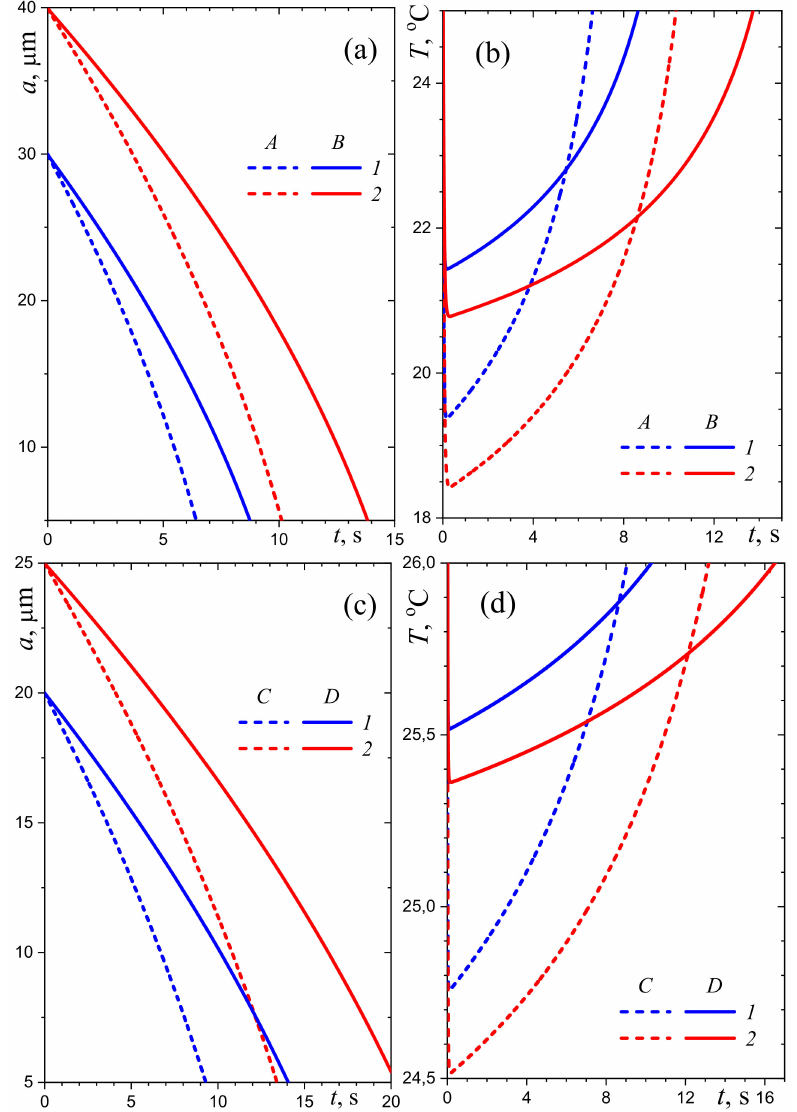
Figure 2. Time-dependency of the droplet radius and temperature ( a , b ) at low RH of air ( A —20%, B —40%; 1 — a 0 = 30 µ m, 2 —40 µ m) and ( c , d ) at high RH of air ( C —70%, D —80%; 1 — a 0 = 20 µ m, 2 —25 µ m); T air = 27 ◦